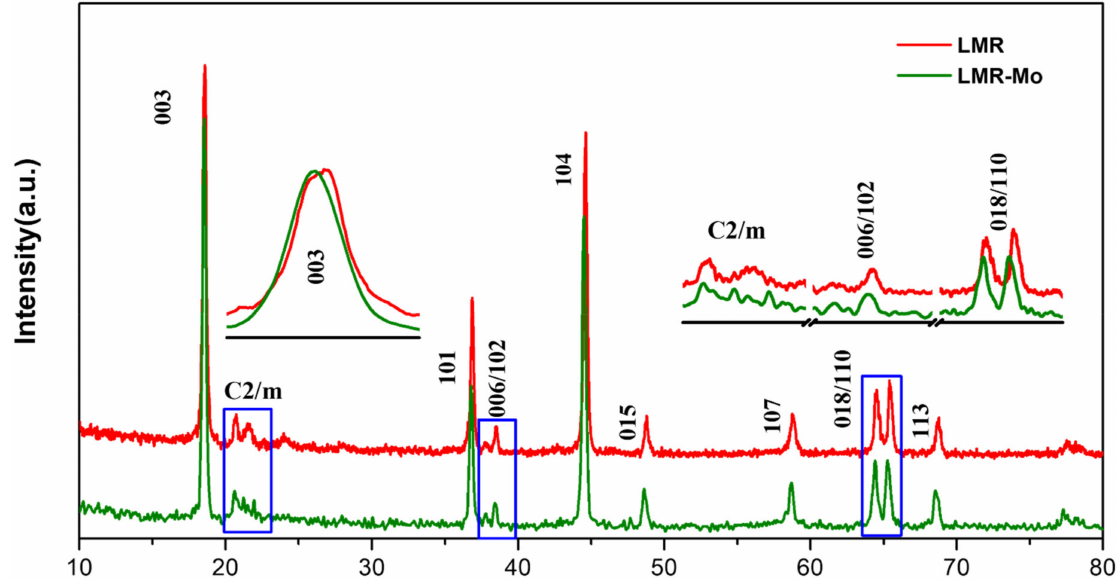
Figure 1. XRD patterns for LMR and LMR-Mo, including enlargement of the 2 θ range.